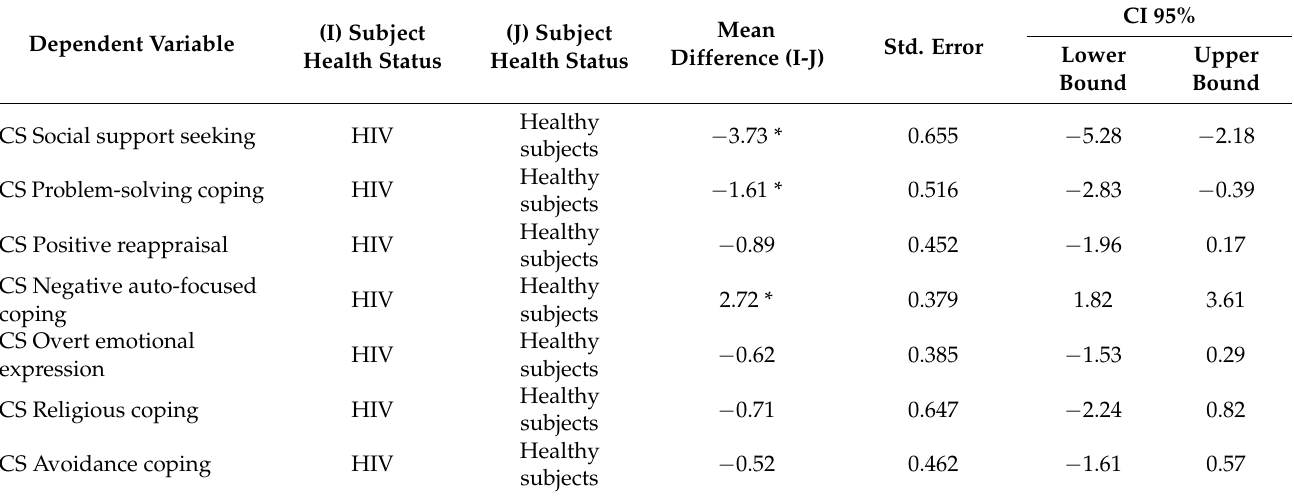
Table 9. Multiple comparisons: coping